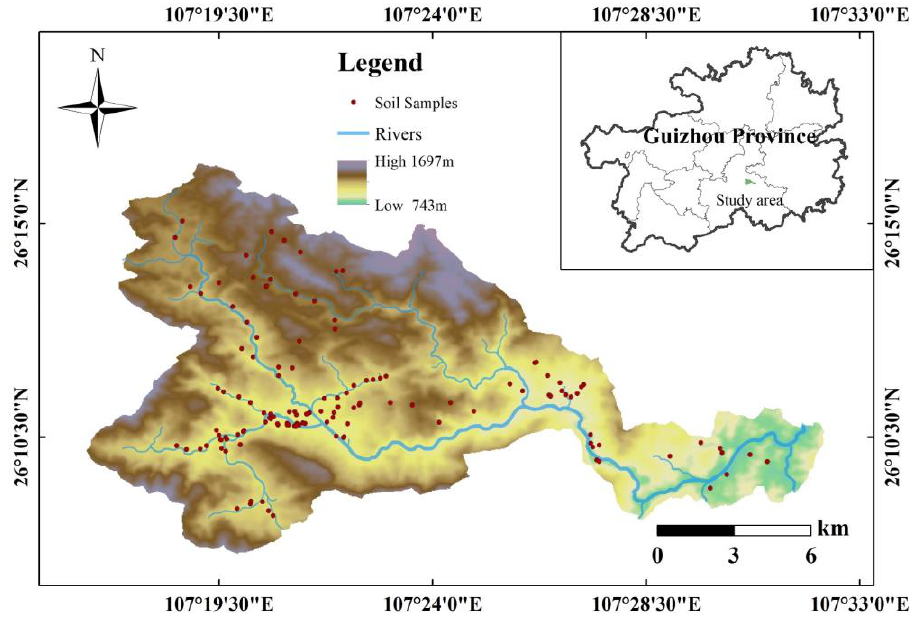
Figure 1. Distribution of watershed locations and sampling sites.